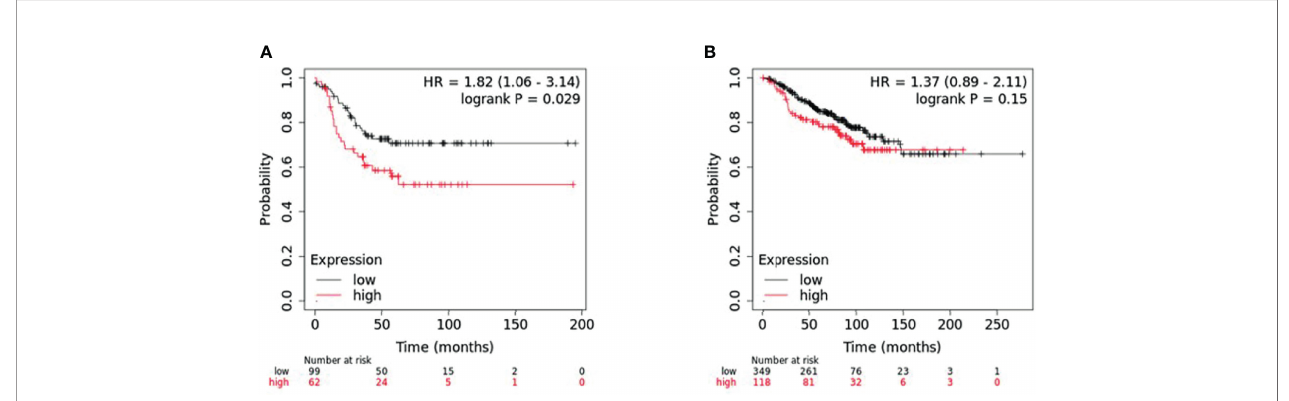
FIGURE 4 | KM plotter survival analysis for patients with differential expression of four-gene panel including ANP32E, DSC2, IL6ST , and ANKRD30A . Survival analysis was performed in KM plotter using publicly available microarray data that is available within the database. (A) TNBC samples (n = 161) and (B) non-TNBC (n = 467) were divided into high or low expression groups based on the median expression of the four-gene panel (with inverted expression of the two low expressed genes: ANKRD30A and IL6ST and not inverted for the two highly expressed genes: ANP32E and DSC2) and compared by Kaplan-Meier survival analysis. A Log-rank p-value ≤ 0.05 was considered signi fi cant. HR, hazard ratio. The red curve represents high expression, and the black curve represents low